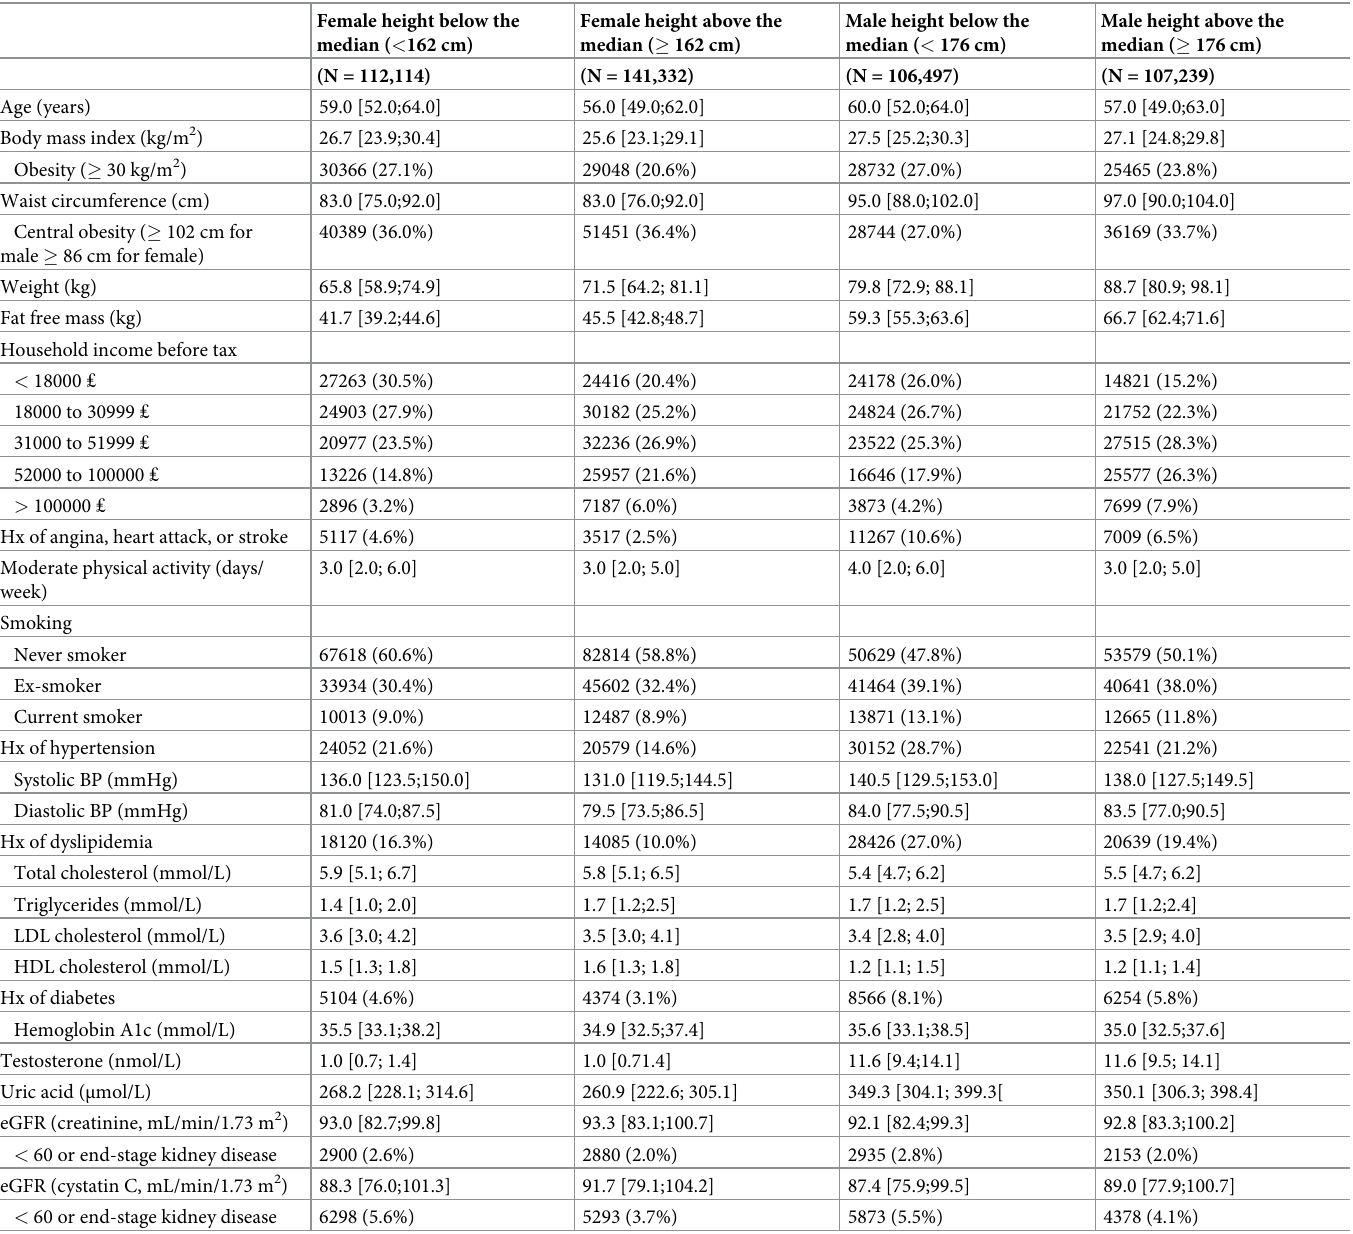
Table 1. Baseline characteristics of the observational analysis dataset in the UK Biobank cohort.